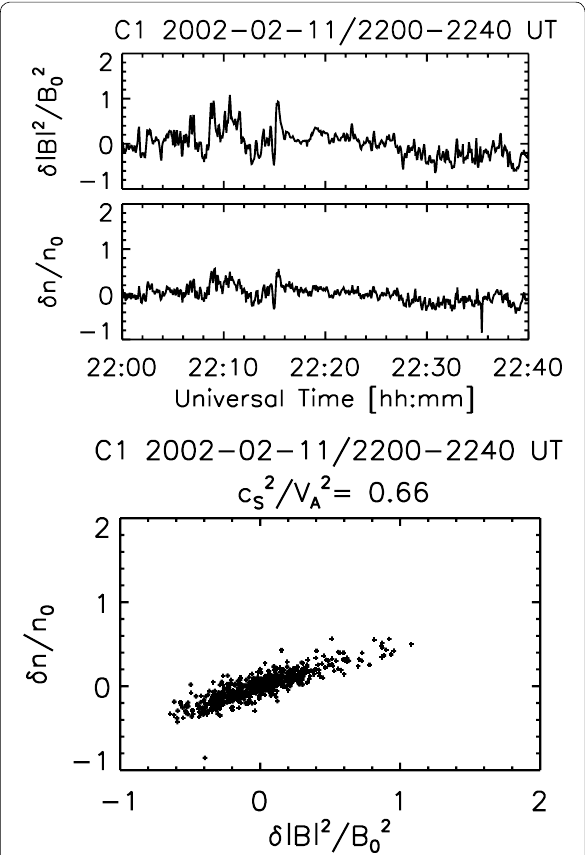
Fig. 1 Time series plot of the fluctuations around the mean field for B 2 the magnetic energy density δ (top panel) and the ion number | | density δ n i (second panel) measured by Cluster-1 spacecraft on 11 February 2002, 2200–2240 UT, and the scatter plot of the two fields (third panel). Value of the ion beta is